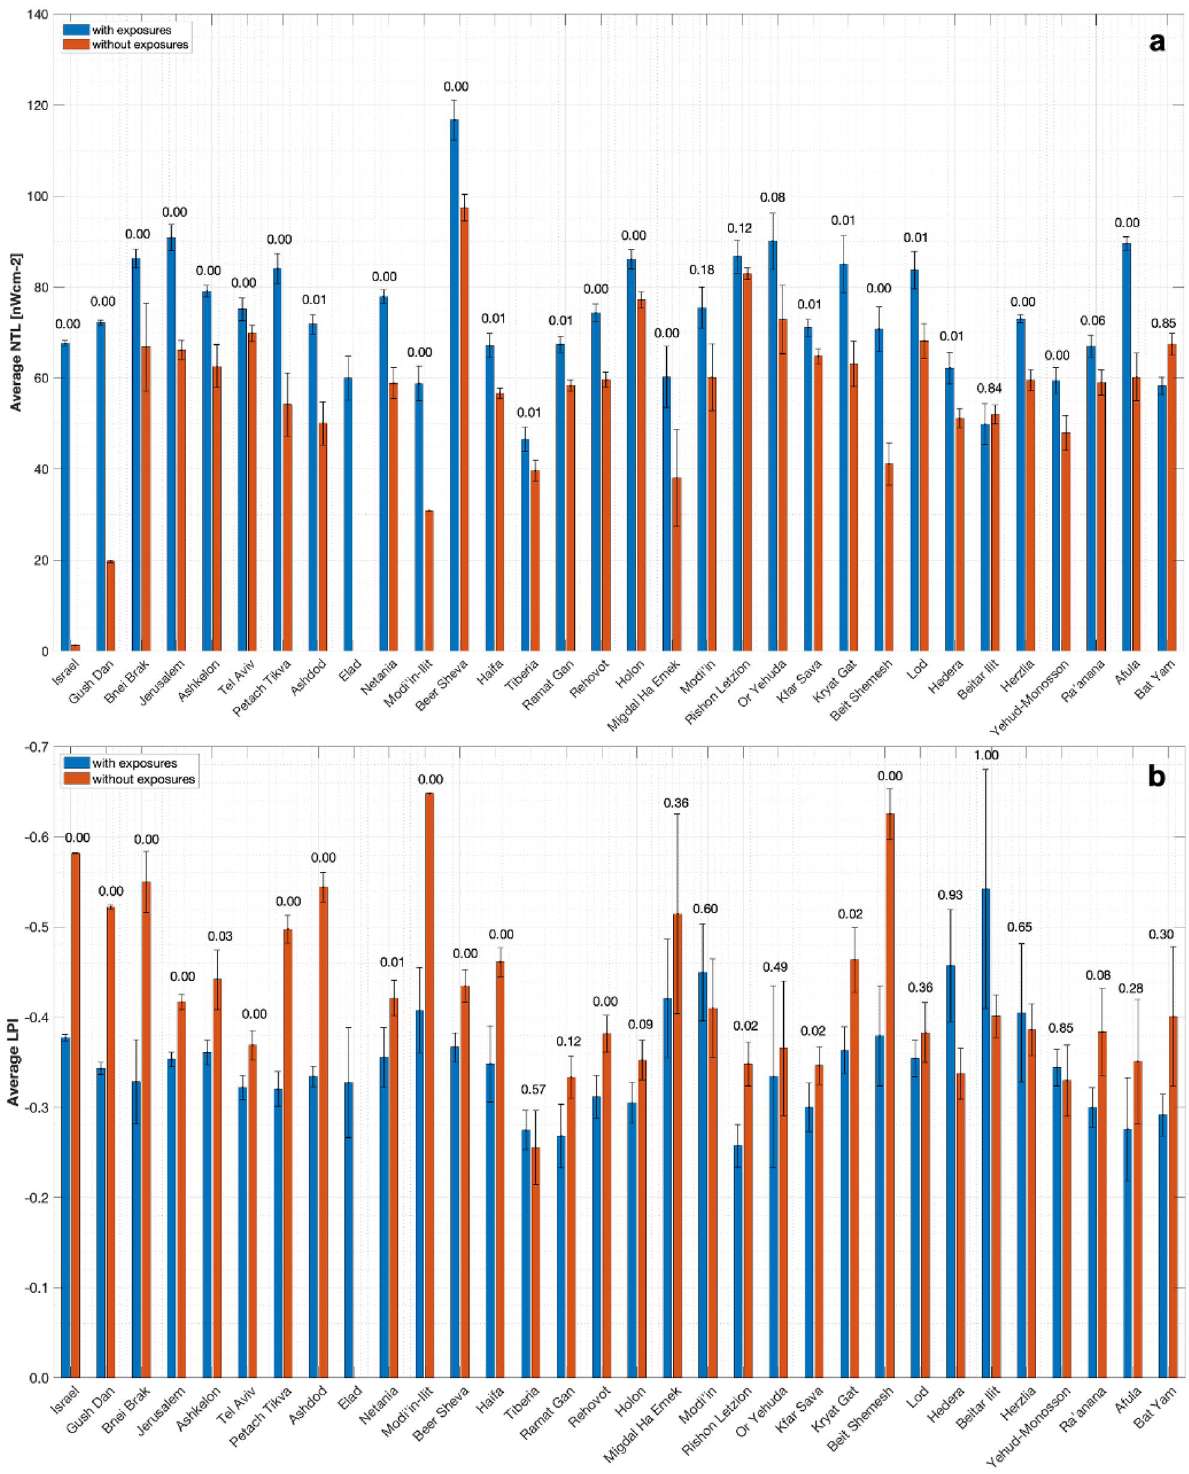
Figure 4. NTL and LPI statistics for our sample. Bar plot showing the mean of (a) NTL and (b) LPI in grid cells with exposures (blue bars) and without exposures (red bars) for the 30 cities with more than 100 reported RLSC cases. For comparison we also present the statistics for the full sample of cities, as well as that for the Gush Dan conurbation. Also denoted above the bars for each city/region are the p-values ( 0 ≤ p ≤ 1 ) with which our null hypothesis—that the average NTL/LPI values for RLSC and for regions with no reported exposures are drawn from the same distribution—holds. Note that in almost all of the cities both NTL and LPI values are significantly higher at locations with finite RLSC